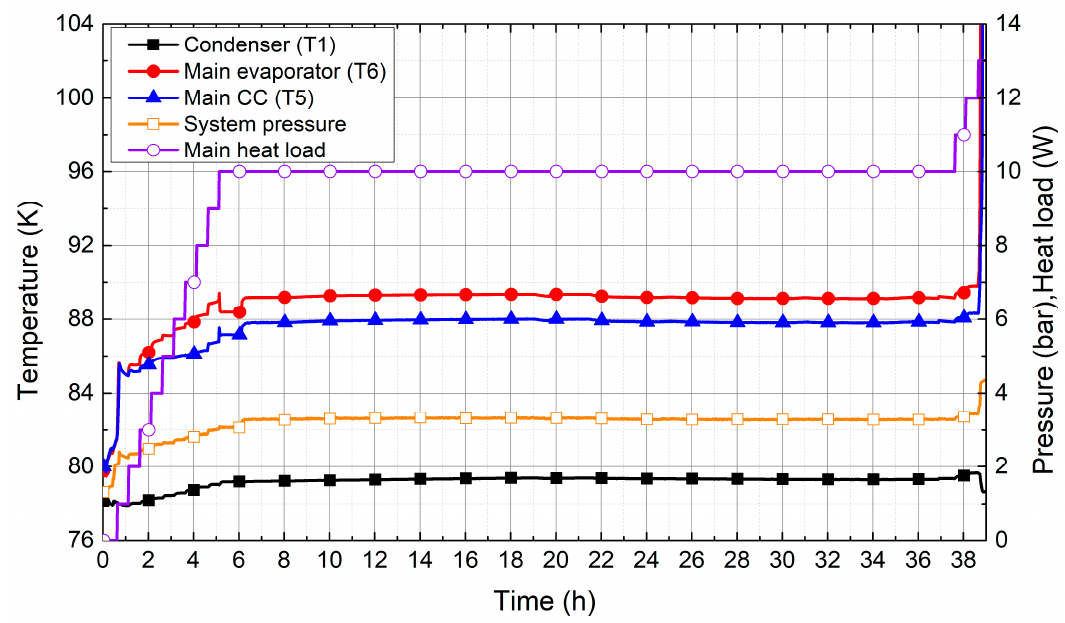
Figure 12. Temperature change over time during a long-duration operation when 55 g nitrogen was in the PRR.